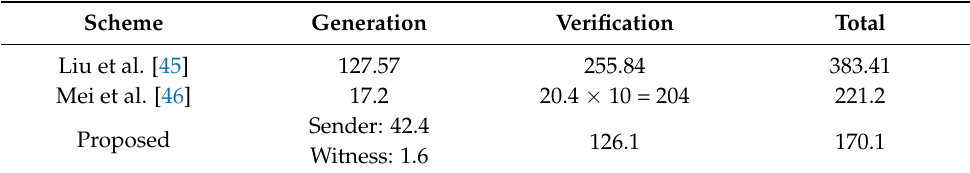
Table 2. Comparison of cryptographic computation cost